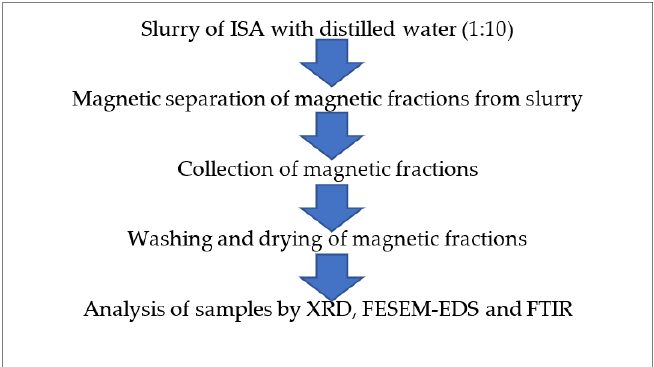
Figure 2. Schematic extraction of magnetic fractions from ISA slurry. (3)